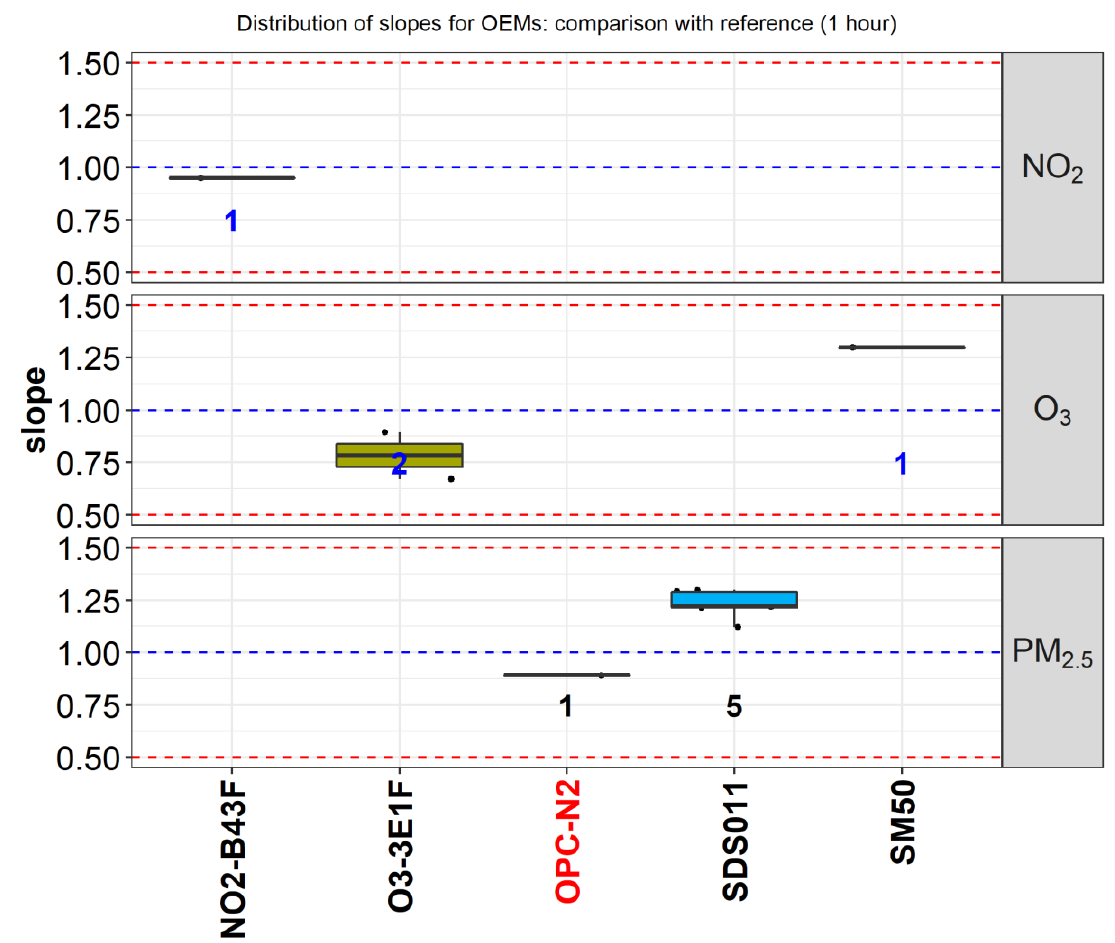
Figure A9. Distribution of slopes from the comparison of OEMs against the reference. Only hourly records with R 2 > 0.7 and 0.5 < slope < 1.5 are shown. Numbers in blue and black indicate the number of open source and black box records, respectively. Names of “living” and “non-living” sensors are indicated by black and red labels on the x-axis, respectively.